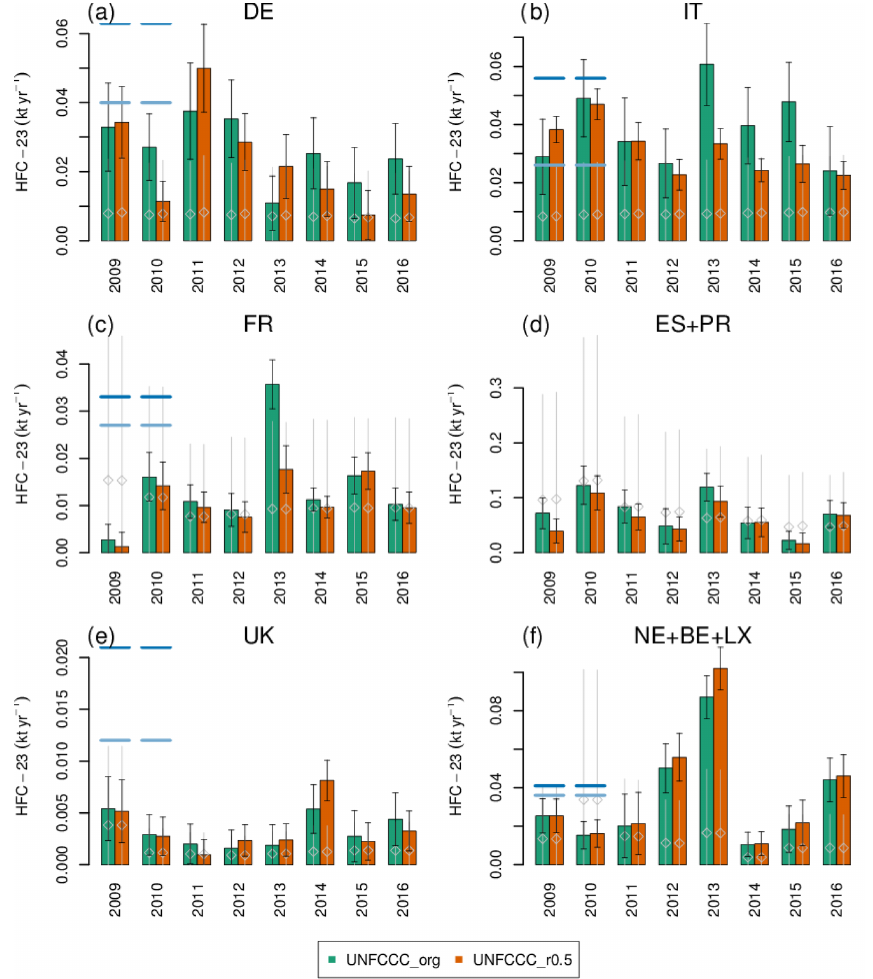
Figure 6. Temporal evolution of national/regional emissions of HFC-23: solid bars and error bars give a posteriori emissions using the two sets of a priori emissions (grey lines). The two approaches (green and orange bars) spatially distribute these different bottom-up estimates (see Sect. 2.7.3). Blue horizontal lines give the estimates of Keller et al. (2011) for their Bayesian (light blue) and point source (dark blue) estimate; (a) Germany (DE), (b) Italy (IT), (c) France (FR), (d) Spain and Portugal (ES + PR), (e) United Kingdom (UK), (f) Benelux countries (Netherlands, Belgium and Luxembourg, NE + BE +